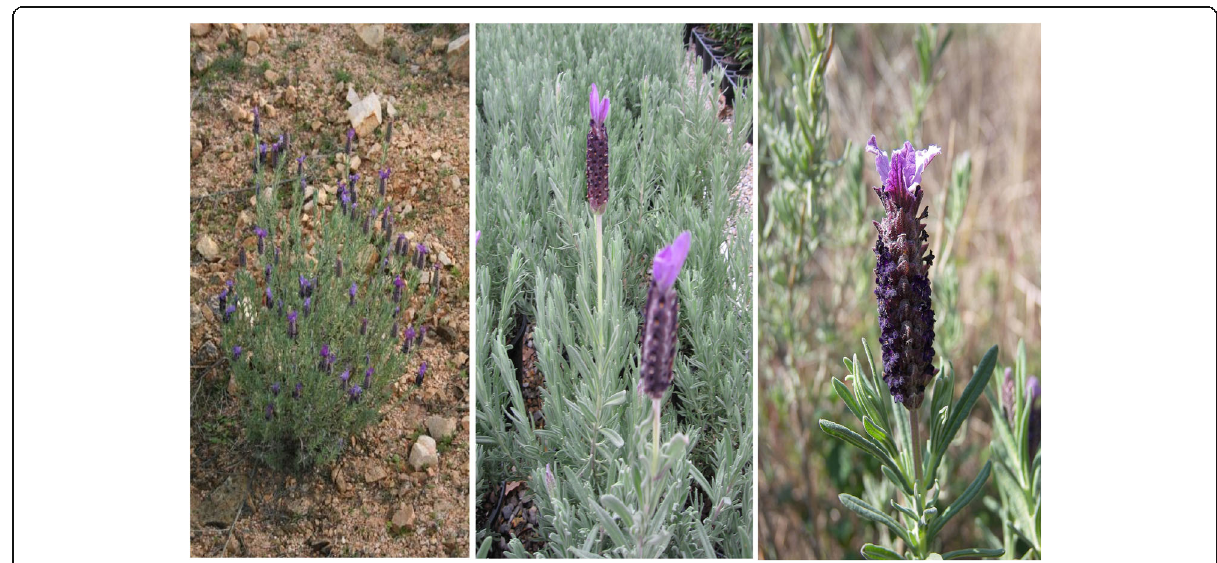
Fig. 1 L. stoechas plants from Taounate city